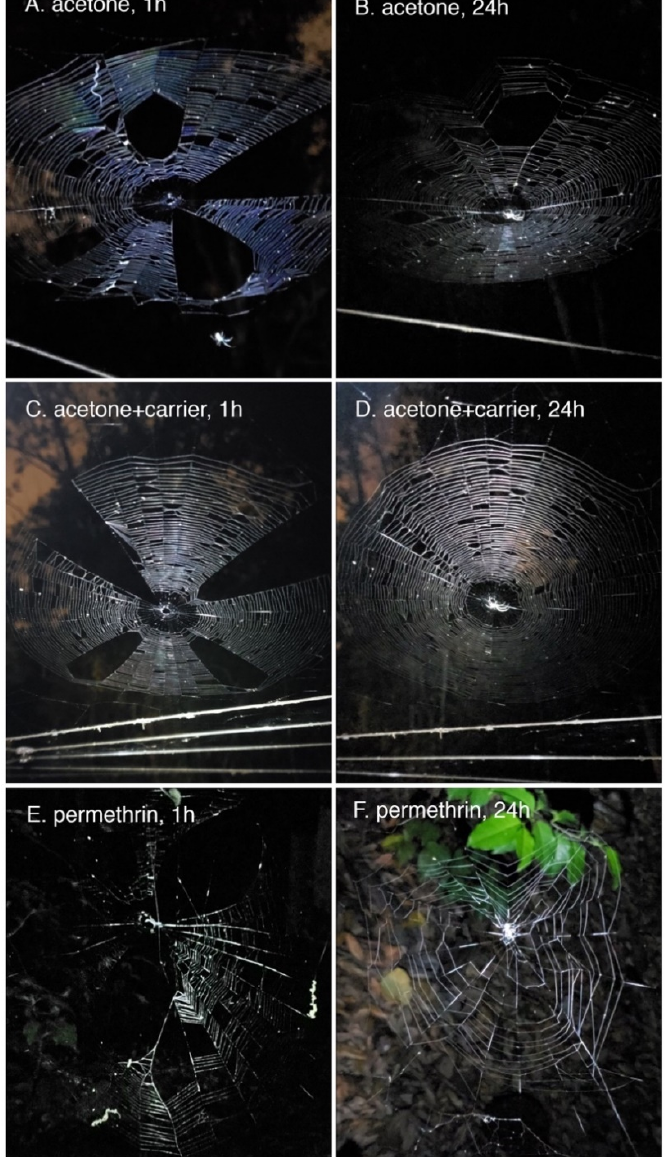
Figure 2. Side by side comparisons of spider webs before ( A , C , E ) and after ( B , D , F ) the residing orchard spiders were exposed to treatments. The control treatments ( A – D ) had no adverse effect on web reconstruction. For the first day after application, permethrin treatment ( E , F ) interfered with the resident spider’s ability to reconstruct a normal web. The few webs that were partially reconstructed (6 of 15) had a significantly smaller web area, and irregular and wide spacing of adhesive spiral strands visible in the permethrin treatment after 24 h ( F ).